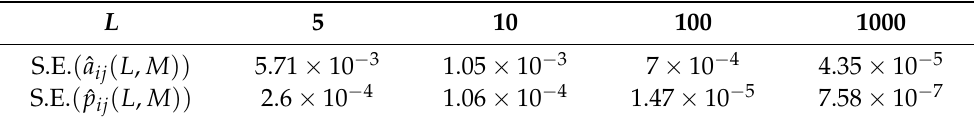
Table 4. Squared errors (S.E.) for the estimators of a ij and p ij in the case of no censoring, for various values of L .